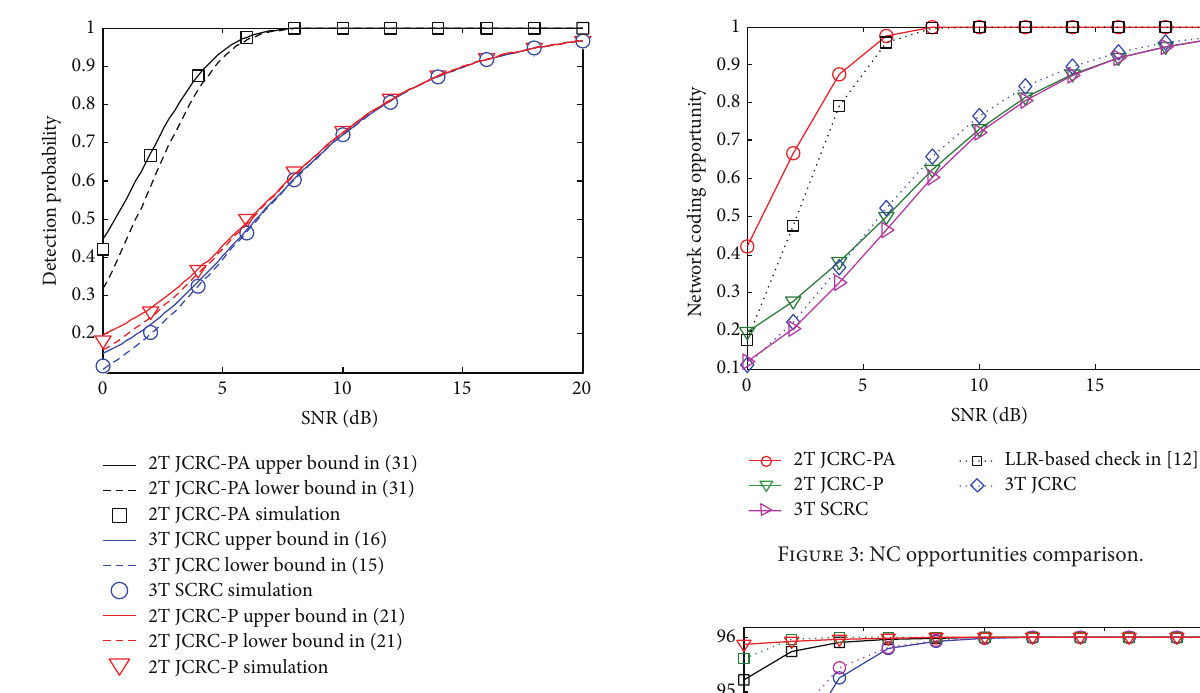
polynomial with the minimum Hamming distance 𝑑 min = 3 .